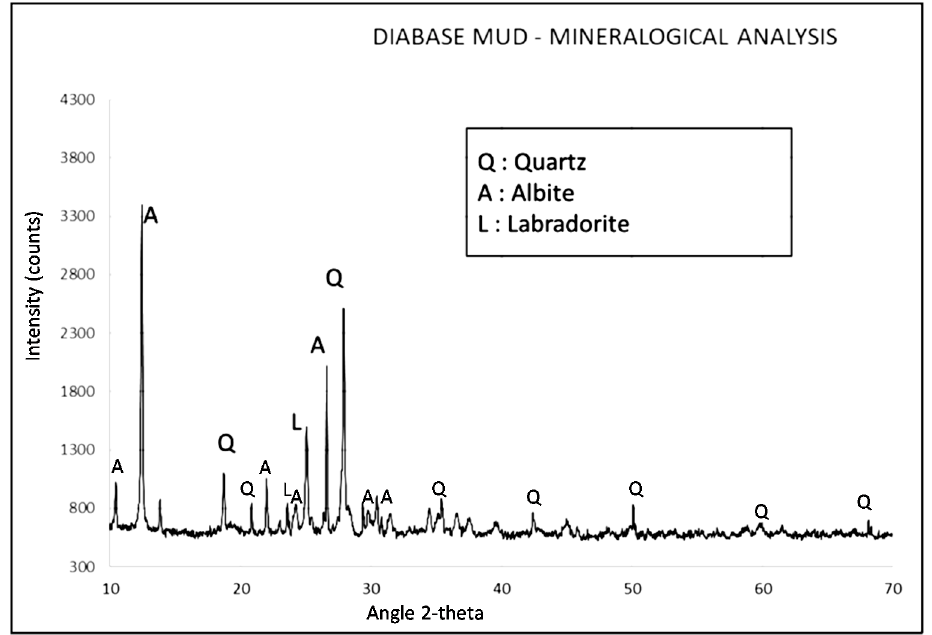
Figure 1. XRD diffractograms of the investigated DM material.